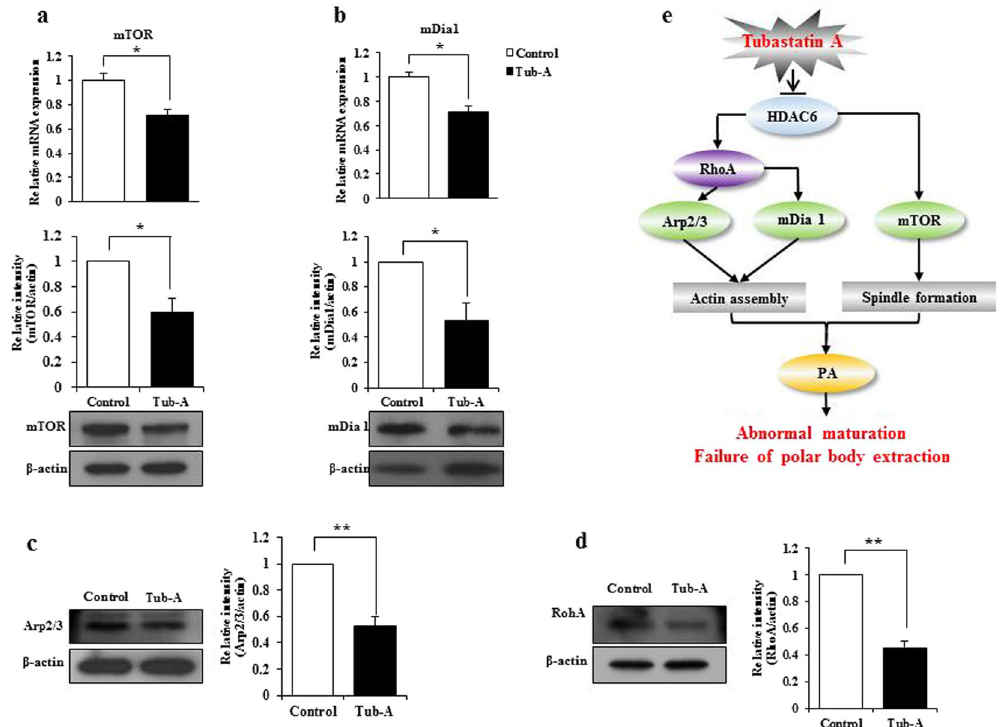
to detect mTOR and mDia1. Values are indicated: * p < 0.05, ** p < 0.01. ( c , d ) Arp2/3 and RhoA protein